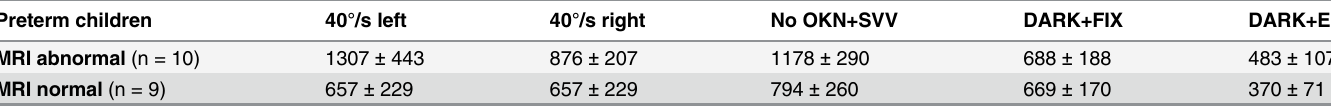
Table 3. Mean surface area of the CoP for the preterm born children with abnormal and normal MRI results. Preterm children 40°/s left 40°/s right No OKN+SVV DARK+FIX DARK+EC MRI abnormal (n = 10) 1307 ± 443 876 ± 207 1178 ± 290 688 ± 188 483 ± 107 MRI normal (n = 9) 657 ± 229 657 ± 229 794 ± 260 669 ± 170 370 ± 71 Mean of Surface of the CoP and the standard error for the fi ve different conditions (OKN+SVV: 40°/s left and 40°/s right, respectively, No OKN+SVV, DARK+FIX and DARK+EC) for the two groups of preterm born children tested with abnormal (10 children) and normal (9 children) MRI results.